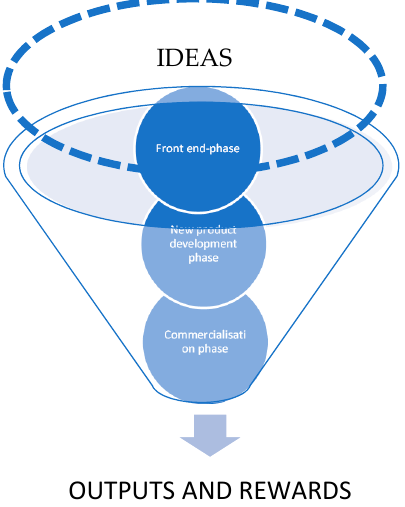
Figure 14. Rewards and knowledge sharing [73], adapted.